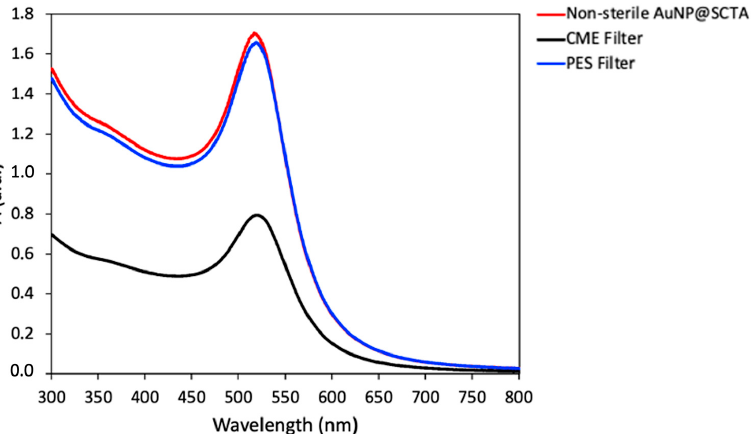
Figure 2. UV-Vis spectra of AuNP-SCTA before and after sterilization with different filter materials. UV-Vis spectra of AuNP-SCTA before (red dashed) and after sterilization with PES (blue) and CME (black) filters were acquired with a Shimadzu UV-2400 spectrophotometer. Absorbance A in arbitrary units (a.u.). The experiment was repeated twice with similar results.